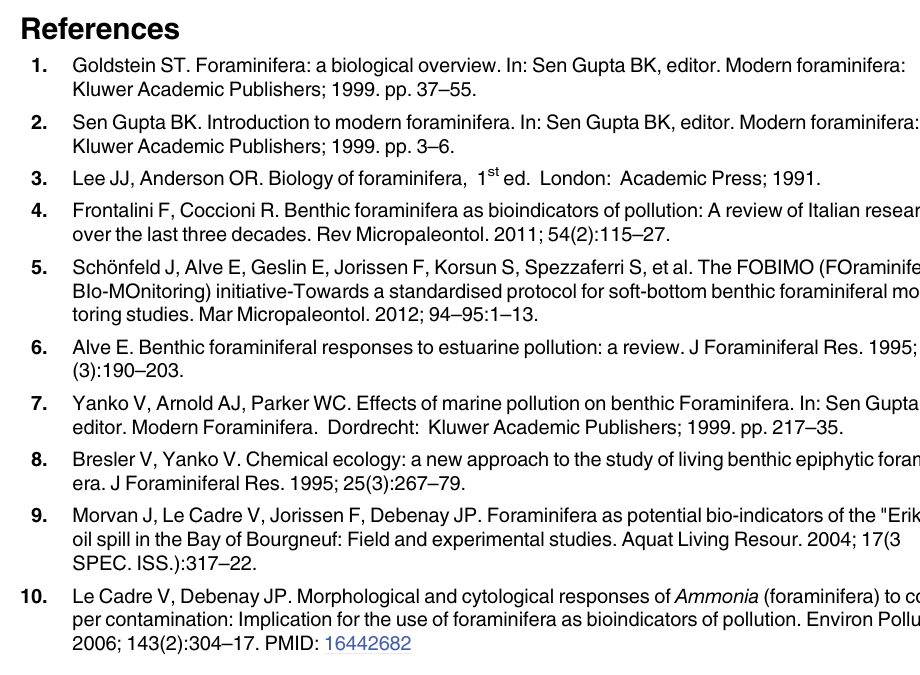
(shown in A) showing the presence of Hg. (D) EDS maps of the SEM image region showing the depletion of carbon and the localized presence of Hg. The EDS maps are taken from the net intensities of the element regions. Each point is the average of 3×3